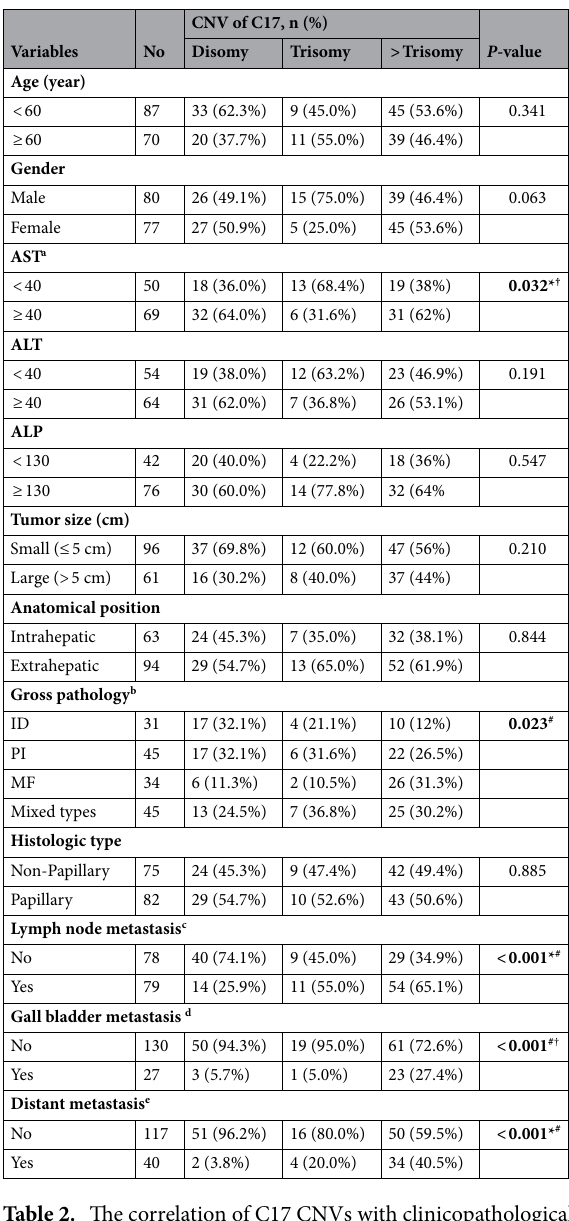
13.194–288.199; P < 0.001), C7/17 trisomy (HR, 28.966; 95% CI 2.796–42.420; P < 0.001), in addition C7/17 > tri- somy (HR, 395.870; 95% CI 18.450–433.42; P < 0.001) were independent predictive factors of poor OS (Table 6). In consideration of C7 aberrations in CCA patients, the OS of the patients with trisomy and > trisomy was significantly shorter than that with normal C7 (log rank P < 0.001; median OS 2.23 vs.13.07 vs.49.77 months), respectively (Fig. 4a). Likewise, the patients with > trisomy C17 and trisomy C17 had shorter OS than those patients with normal C17 (log rank P < 0.001; median OS 3.03 vs.15.53 vs.45.83 months) (Fig. 4b). Moreover, the patients with > trisomy of C7/17 and trisomy of C7/17 had shorter survival time than those patients with normal C7/17 (log rank P < 0.001; median OS 2.23 vs.15.33 vs. 50.23 months), respectively (Fig. 4c).